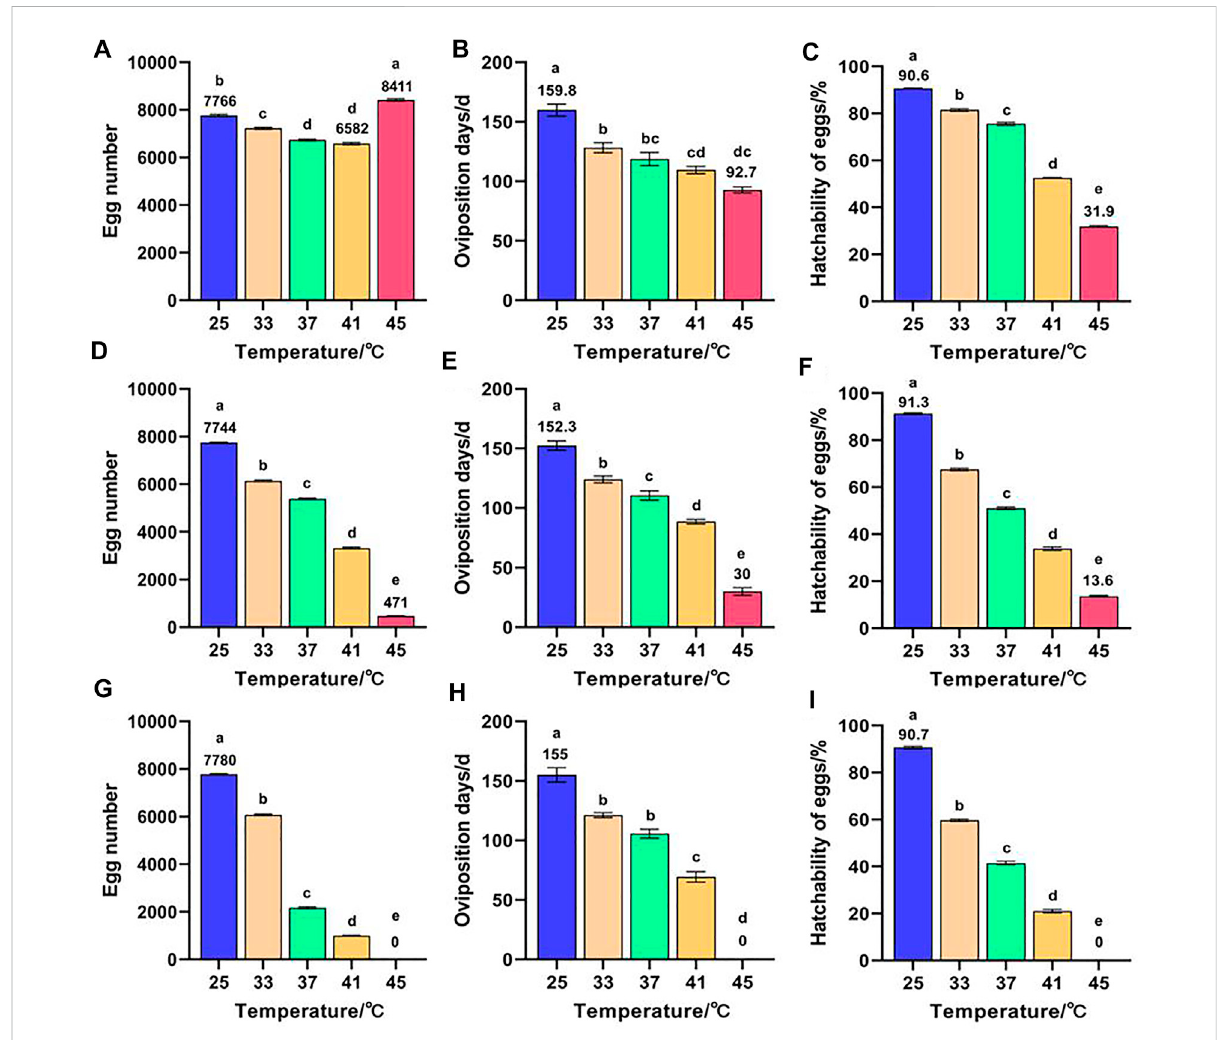
FIGURE 2 Effects of short-term high temperature on the reproduction of Z. cucurbitae (Coquillett). (A) Egg number of F 1 ( F = 268.599, p = 0.0001). (B) Oviposition days of F 1 ( F = 34.15, p = 0.0001). (C) Hatchability of eggs of F 1 ( F = 3,456.539, p = 0.0001). (D) Egg number of F 2 ( F = 8,460.934, p = 0.0001). (E) Oviposition days of F 2 ( F = 200.296, p = 0.0001). (F) Hatchability of eggs of F 2 ( F = 3,305.611, p = 0.0001). (G) Egg number of F 3 ( F = 12,589.238, p =0.0001). (H) OvipositiondaysofF 3 ( F =228.794, p =0.0001). (I) HatchabilityofeggsofF 3 ( F =4,570.108, p =0.0001).Allvaluesin the fi gure are presented as mean ± standard error. Letters above the bars indicate signi fi cant differences ( p ≤